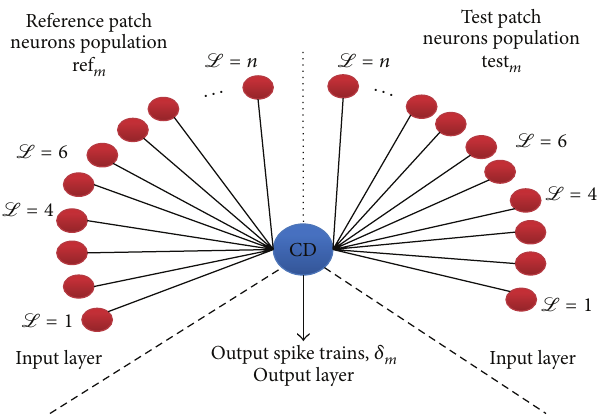
Figure 6: Illustration of a CD neuron (center) attached to single patch of face receiving presynaptic inputs attached to locally lateral LP 𝑚 from gallery face and probe face. Each neuron connected to the CD neuron patch assumes spatially different input L to ensure that spatiotemporal information is intact. This coincidence detection implementation adopts a feed-forward 2-layer neural network approach comprising an input layer and an output layer.